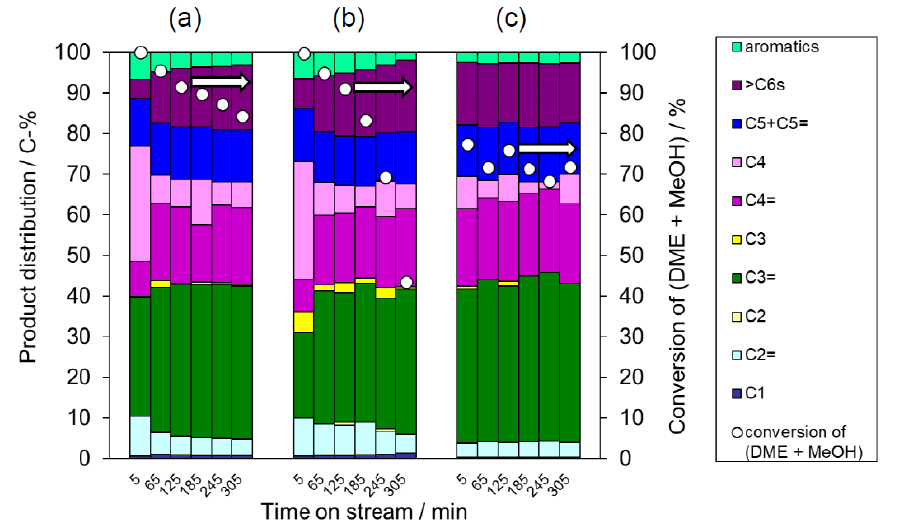
Figure 8. Results from the DTO reaction over the ( a ) deAl-[YFI-C + 3 wt% MFI nano (20)] (Si/Al = 62), ( b ) deAl-[YFI-C + 3 wt% MFI micron (20)] (Si/Al = 62), and ( c ) deAl-[Si 3 N 4 + 3 wt% MFI nano (20)].